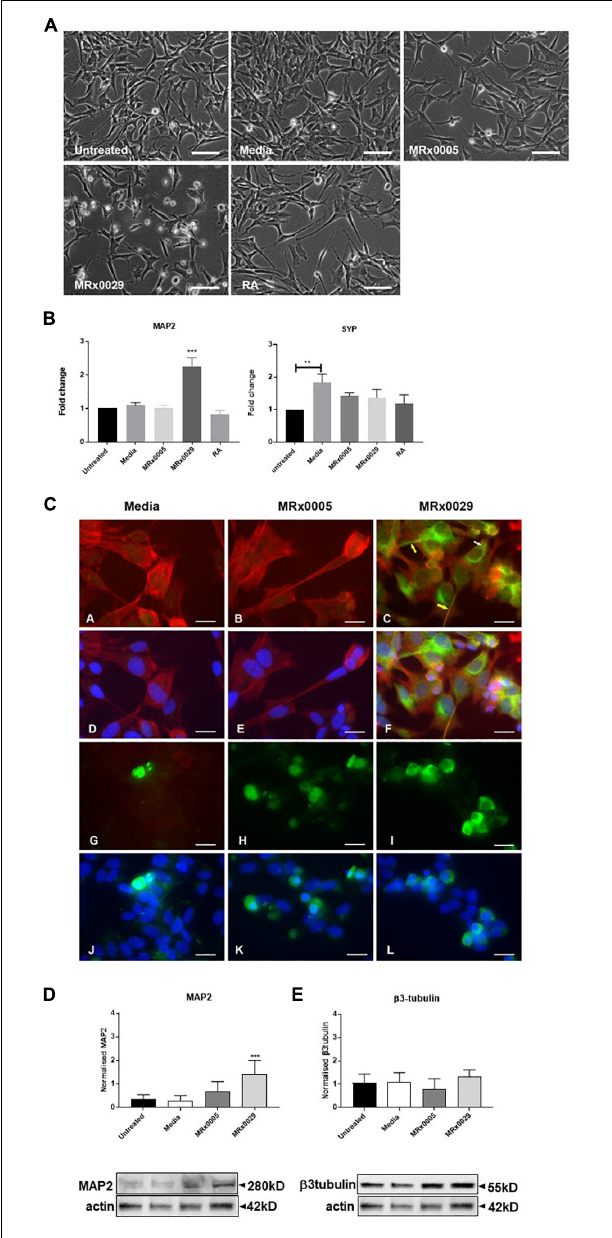
FIGURE 3 | MRx0029 induced SH-SY5Y cells differentiation. Undifferentiated SH-SY5Y cells were treated with 10% MRx0005, MRx0029, media, 10 µ M RA for 24 h. (A) Representative images using phase contrast microscope to show differences in morphology. Magnification 400 × . Scale bar = 10 µ m (B) Treated cells as described above were collected, total RNA isolated for qPCR to quantify MAP2 and SYP gene expression. Data are mean ± SEM ( n = 3). (C) (a–c) Representative images of immunolabelled cells with Phalloidin (red) and MAP2 (green), (d–f) and merged with DAPI (blue) images; (g–i) β 3-tubulin immunolabelled cells (green) and (j–l) merged with DAPI (blue) images. Magnification 630 × . Scale bar = 5 µ m. (D,E) Western blot analysis of effects of MRx0005 and MRx0029 treatment on SH-SY5Y cells. Western blot membranes were probed with antibodies to (D) MAP2 and (E) β 3-tubulin. Actin was used as a loading control. Lower panels: representative blots from one of five separate experiments; upper panels: relative densitometric intensity. Data are mean ± SEM ( n =